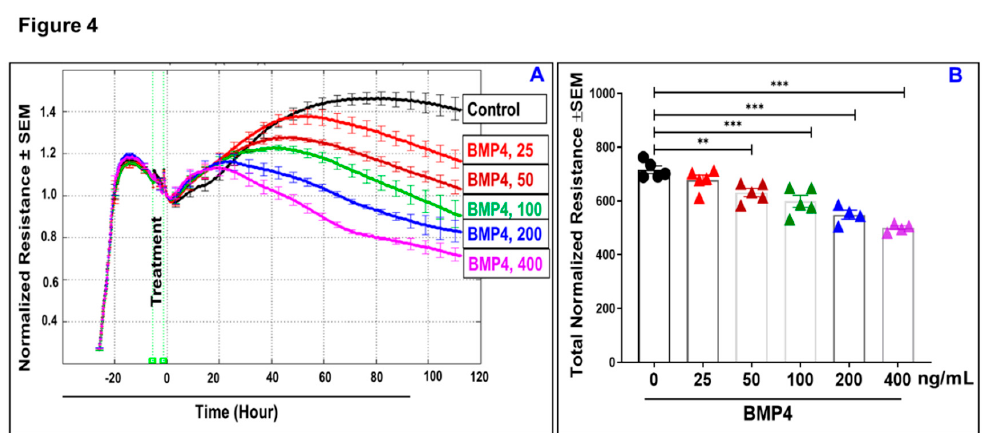
Figure 3. Three-D model representation for the effect of BMP4 on ARPE-19 barrier functionality. BMP4-treatment was initiated after ARPE-19 cells formed confluent monolayers indicated by the plateau in the resistance, y -axis shown in the representative 3D model. Thereafter, monolayers of ARPE-19 cells were treated with BMP4 at different concentrations (0, 25, 50, 100, 200, or 400 ng/mL; ( A – F ), respectively) and the barrier integrity was monitored over a 100-h period (represented on the z -axis) as well as across 9 frequencies (250, 500, 1000, 2000, 4000, 8000, 16,000, 32,000 and 64,000 Hz, represented as log values on the x -axis). As shown in ( A – F ), BMP4 reduced the resistance of ARPE-19 cells in a dose dependent manner compared to the vehicle-treated control cells over the experimental period and across all tested frequencies; n = 4–6.